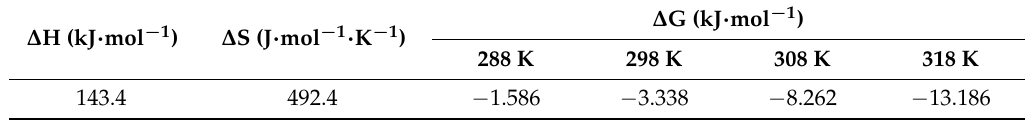
Table 5. Thermodynamic parameters for EBT adsorption by